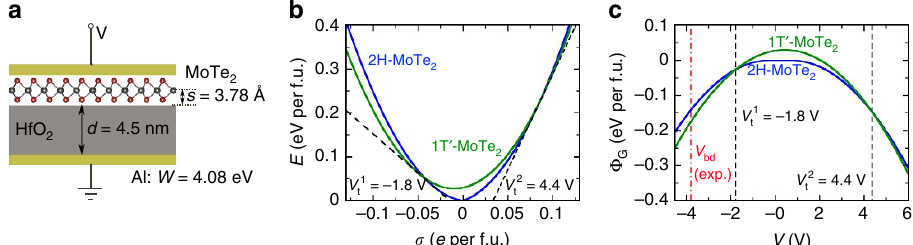
Figure 4 | Phase boundary at constant voltage and stress. ( a ) Monolayer MoTe 2 deposited on top of a HfO 2 layer of thickness d ¼ 4.5nm, which is on top of an aluminum plate of work function W ¼ 4.08eV. Voltage V is applied between the monolayer and the aluminum plate. ( b ) Plotted is the total energy E of the capacitor shown in a as a function of the charge density s on monolayer MoTe 2 . ( c ) Plotted is the grand potential F G as a function of the gate voltage V . The blue line represents a capacitor containing 2H-MoTe 2 , whereas the green line represents a capacitor containing 1T 0 -MoTe 2 . The two black dashed lines in b depict common tangents between the 2H and 1T 0 energy surfaces, and in c represent intersections of the 2H and 1T 0 grand potentials indicating two transition voltages V t 1 and V t 2 . Between the two transition voltages, semiconducting 2H-MoTe 2 has a lower grand potential and is thermodynamically stable. Outside this range, 1T 0 will be more stable. The red dashed line in c represents a breakdown voltage 35 obtained experimentally for a HfO 2 film of thickness 4.5nm. The separation between MoTe 2 centre and the surface of HfO 2 is assumed to be s ¼ 3.78Å, and both 2H and 1T 0 are structurally relaxed (constant stress) in b and c . NATURE COMMUNICATIONS|7:10671|DOI: